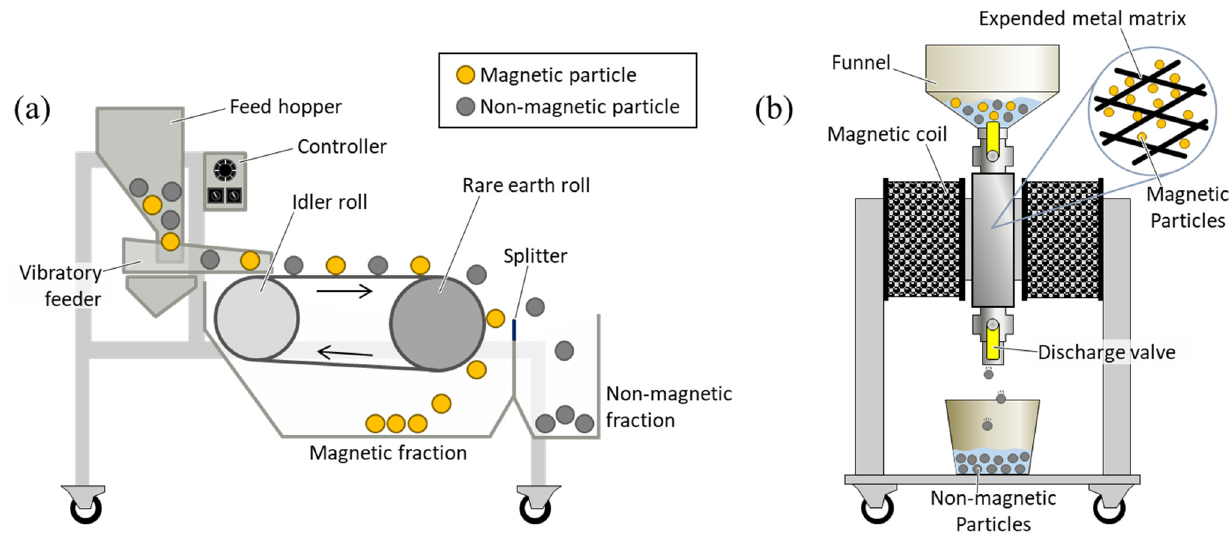
Figure 2. Schematic diagrams of ( a ) dry high-intensity magnetic separator and ( b ) wet high-intensity magnetic separator.